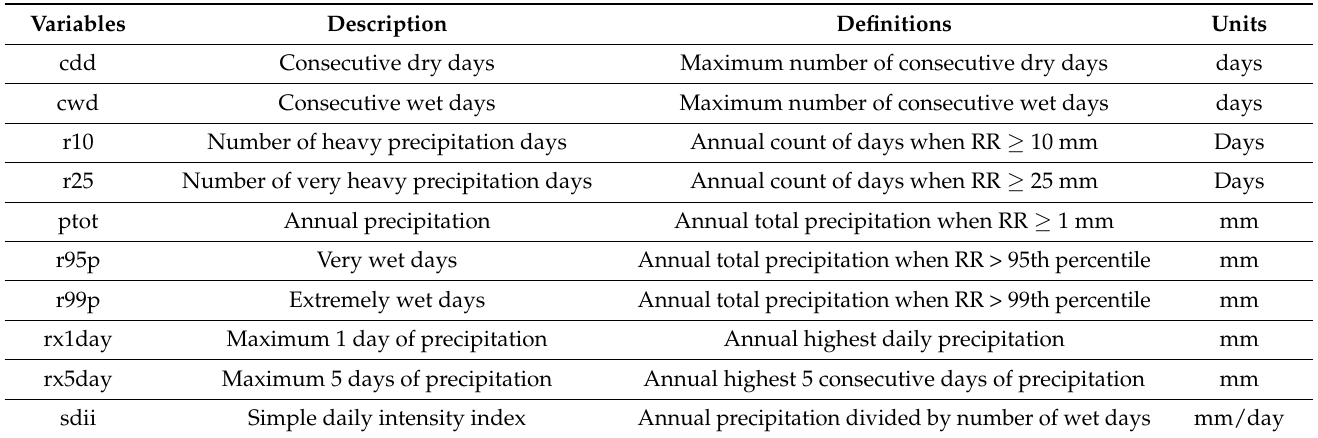
Table 2. Definition of ETCCDI indices based on daily precipitation and